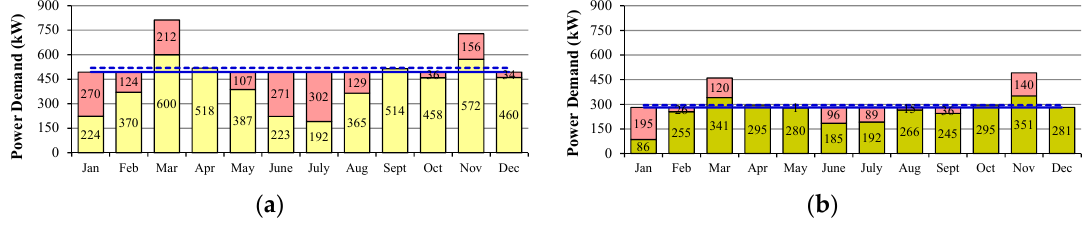
Figure 5. Scenario 1 demand values for ( a ) off-peak ( b ) on-peak.